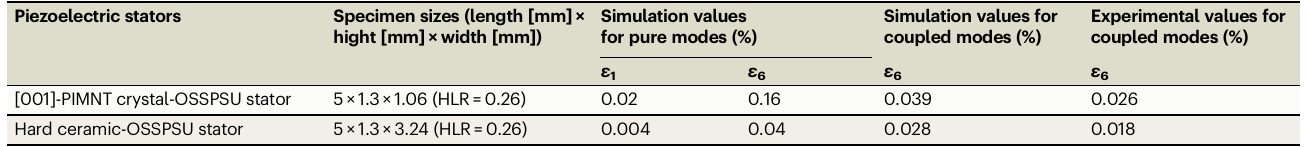
Table 1 | The simulated and tested results of strains of arti fi cial 31-mode ( ε 1 ), 36-mode ( ε 6 ), and 31 – 36 coupled mode ( ε 6